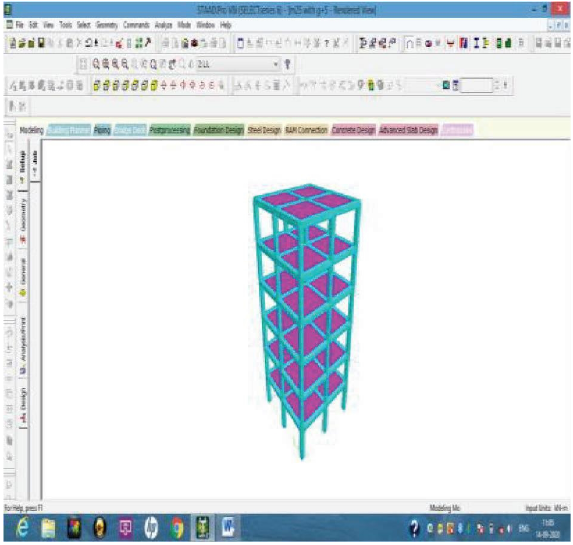
Figure 16: 3D view of G + 5 RC structures.